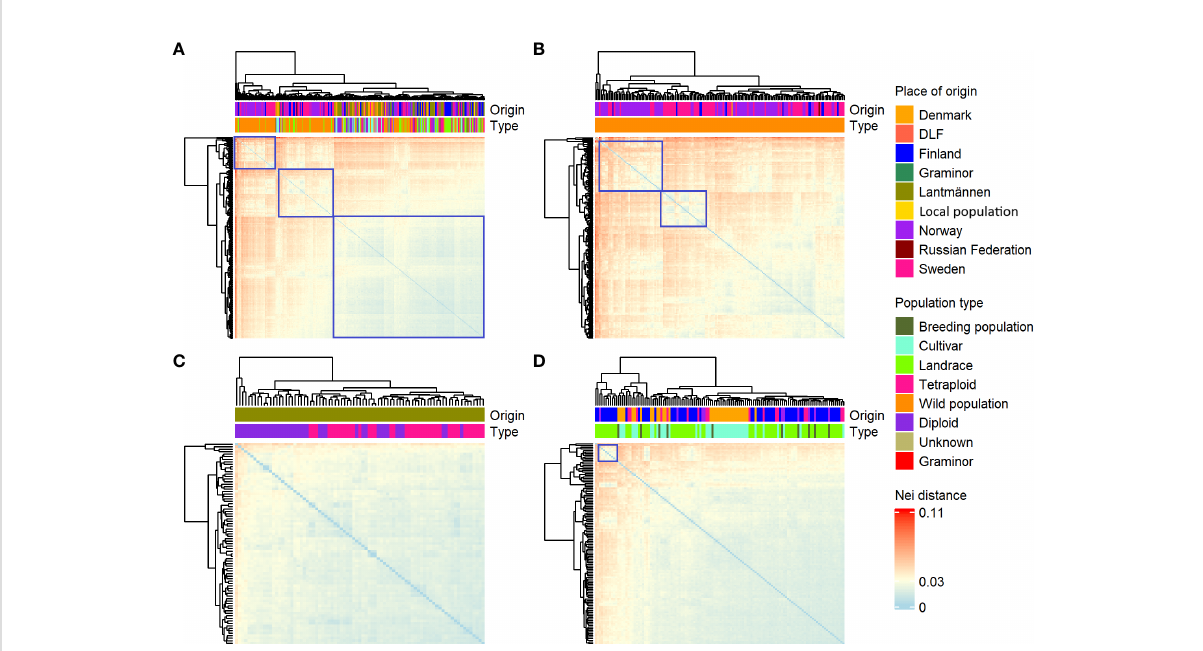
FIGURE 3 A heatmap depicting Nei ’ s standard genetic distances between each pair of populations. The colors indicate high (red), intermediate (yellow) or low (blue) genetic distances. The accessions were clustered according to their pairwise genetic similarities. The accessions included were (A) all 382; (B) WildOnly those that are wild; (C) PopulationsOnly those from Lantmännen; and (D) Cultivarsonly cultivars and landraces from